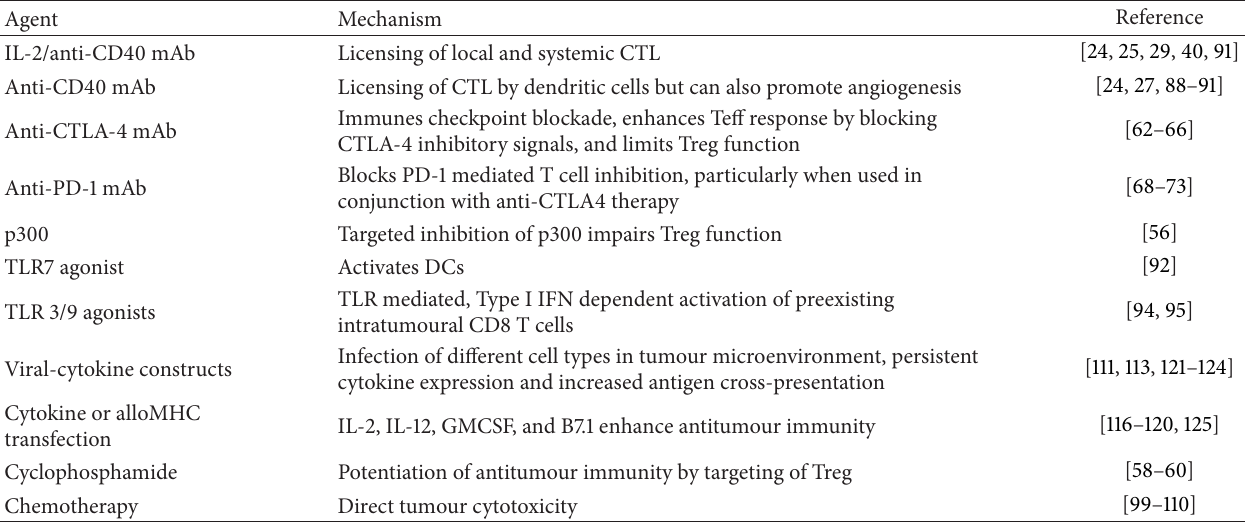
Figure 4: Illustration of the ways in which “Trojan Horse” approaches immunotherapy might be effective. Tumors that are destroyed by local therapy (1) deliver tumor antigens into the draining lymph node (2), that is, the tumor acting as its own vaccine. This cross-primes an antitumor T cell response which, when the tumor vasculature is modified to encourage entry into the tumor (3), results in the accumulation of effector T cells in the tumor. Once local suppressive defenses are overcome (4) and a milieu that is conducive to local effector events is established (5), tumor destruction can result. Table 1: Immunotherapies with a demonstrated local antitumour